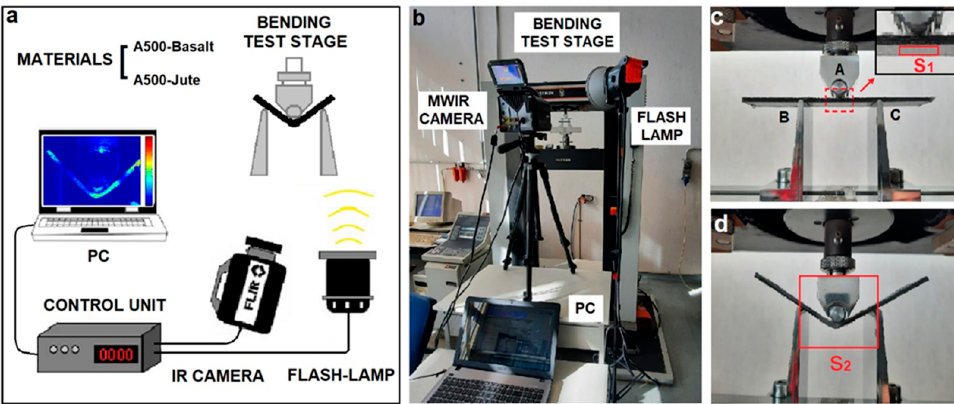
Figure 2. Experimental set-up for infrared imaging analysis during inline quasi-static flexural test: scheme of the experimental set-up ( a ), image of the experimental set-up ( b ), and image of a specimen at the beginning ( c ) and at the end ( d ) of the test. In ( c ) A indicates the central fixed nose while B and C the lateral dynamic ones. In ( c ) S 1 indicate the area of the specimens considered in the passive analysis while in ( d ) S 2 the area considered in the active approach.